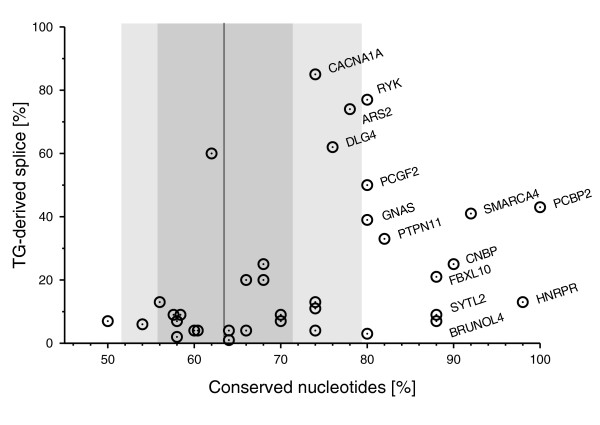
Intron flank conservation of TG-AG splice acceptor tandems. Orthologous human/mouse intron-exon boundaries involving TG splice sites are displayed in a two-dimensional plot according to two properties: horizontal axis = sequence identity of 50 nt sequence upstream of both splice sites; vertical axis = relative abundance of the TG-derived splice variant, as reflected by the fraction of TG-spliced ESTs (except for CACN1A1, where the data are taken from Table 2). Data points are labeled with the gene symbol if the conservation score and/or the fraction of TG-derived splice variant are significantly high. Conservation properties of canonical introns are indicated by shaded intervals: black line = median; dark gray = 66% percentile; light gray = 90% percentile.